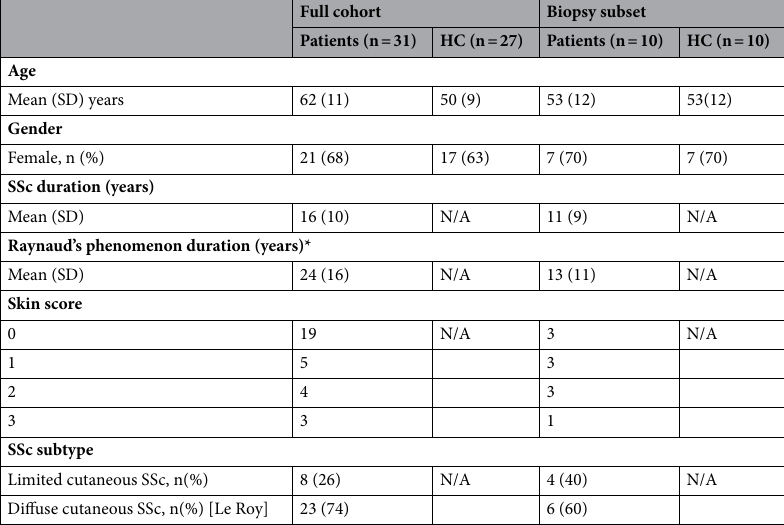
Table 1. Demographic details of participants. *Raynaud’s phenomenon, cold hands with colour changes is often the first symptom of